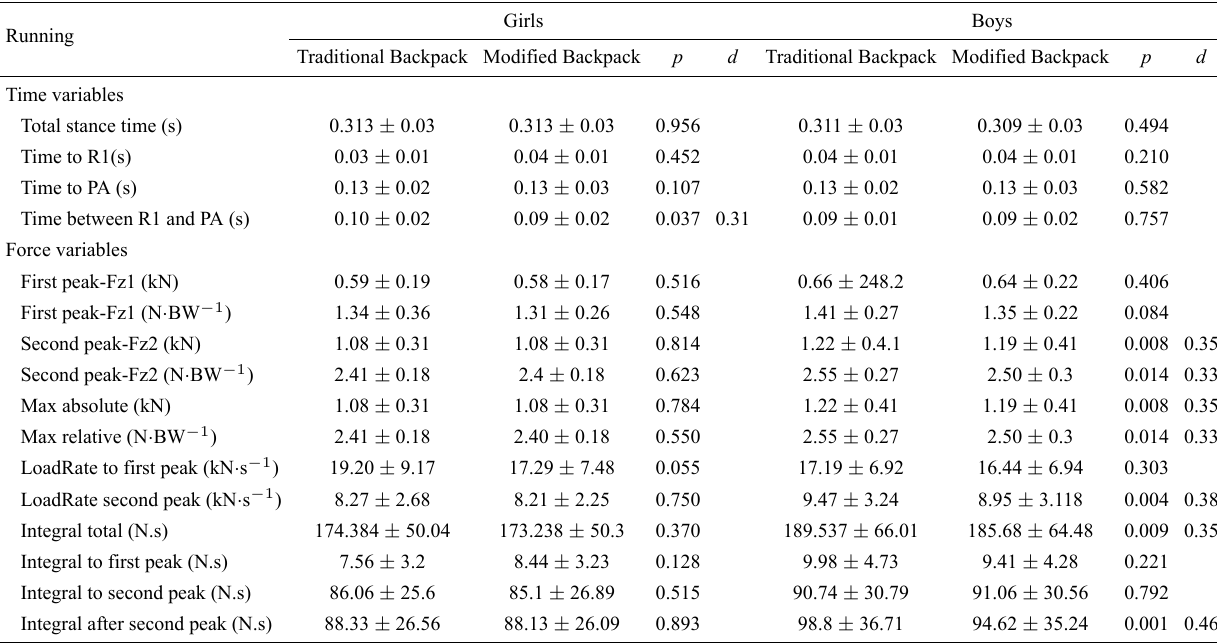
Table 4. Time and force variables (mean ± standard deviations) for boys and girls while running with the traditional backpack and with the modified